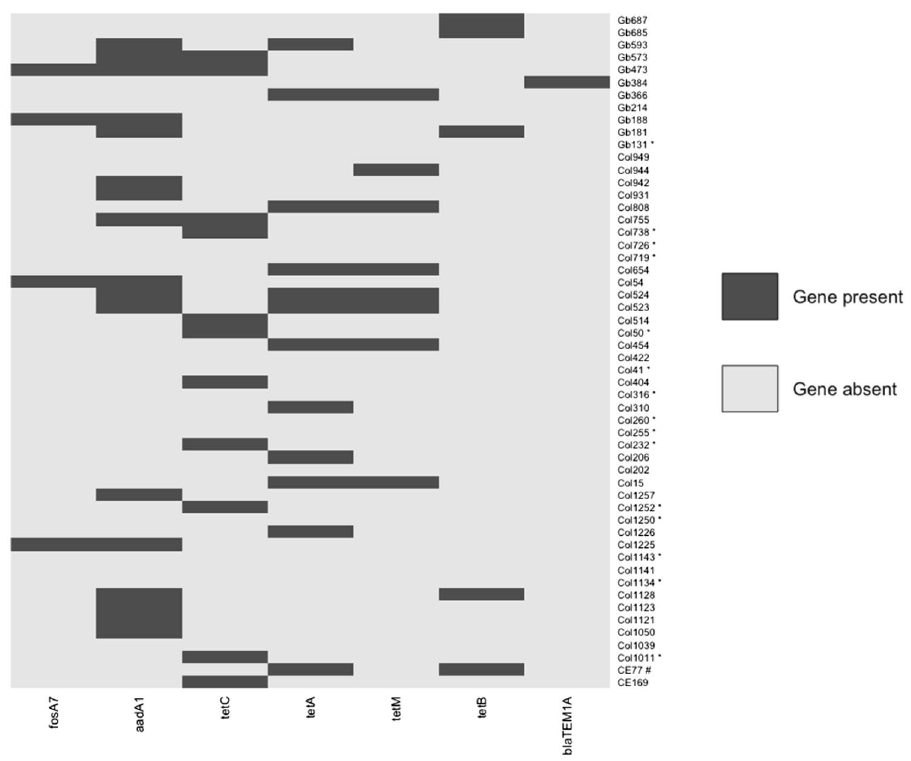
Figure 5. Distribution of acquired antibiotic resistance genes in clb + E. coli . Heat map was created and visualized using ggplot2 package of R. Column represents E. coli isolates and row represents acquired antibiotic resistance genes. *, Phylogroup B2; # Phylogroup